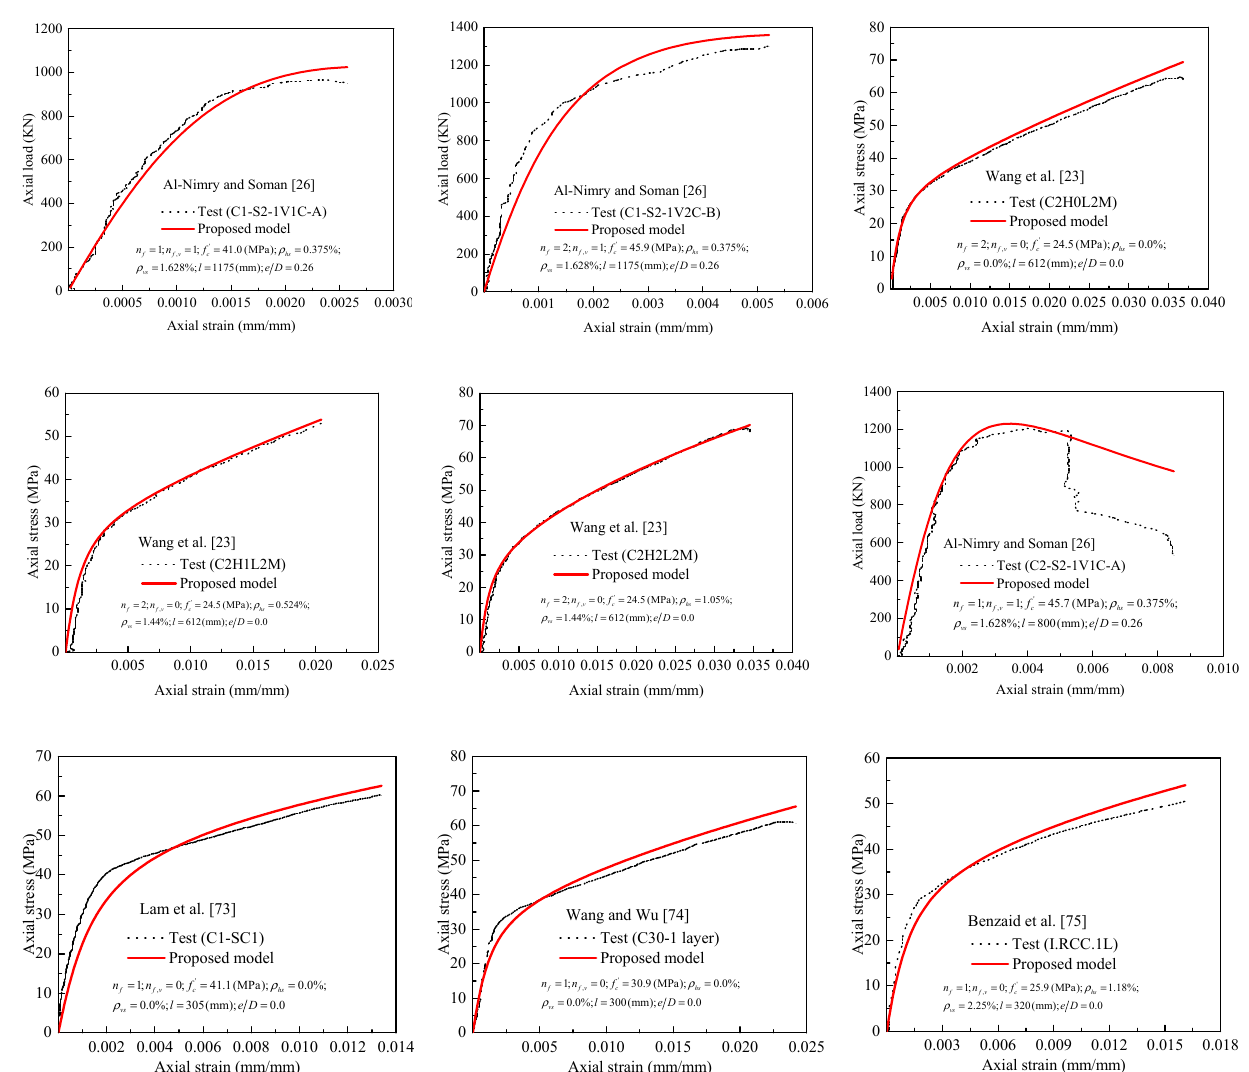
Figure 10. Evaluation of proposed stress–strain model against experimental results.